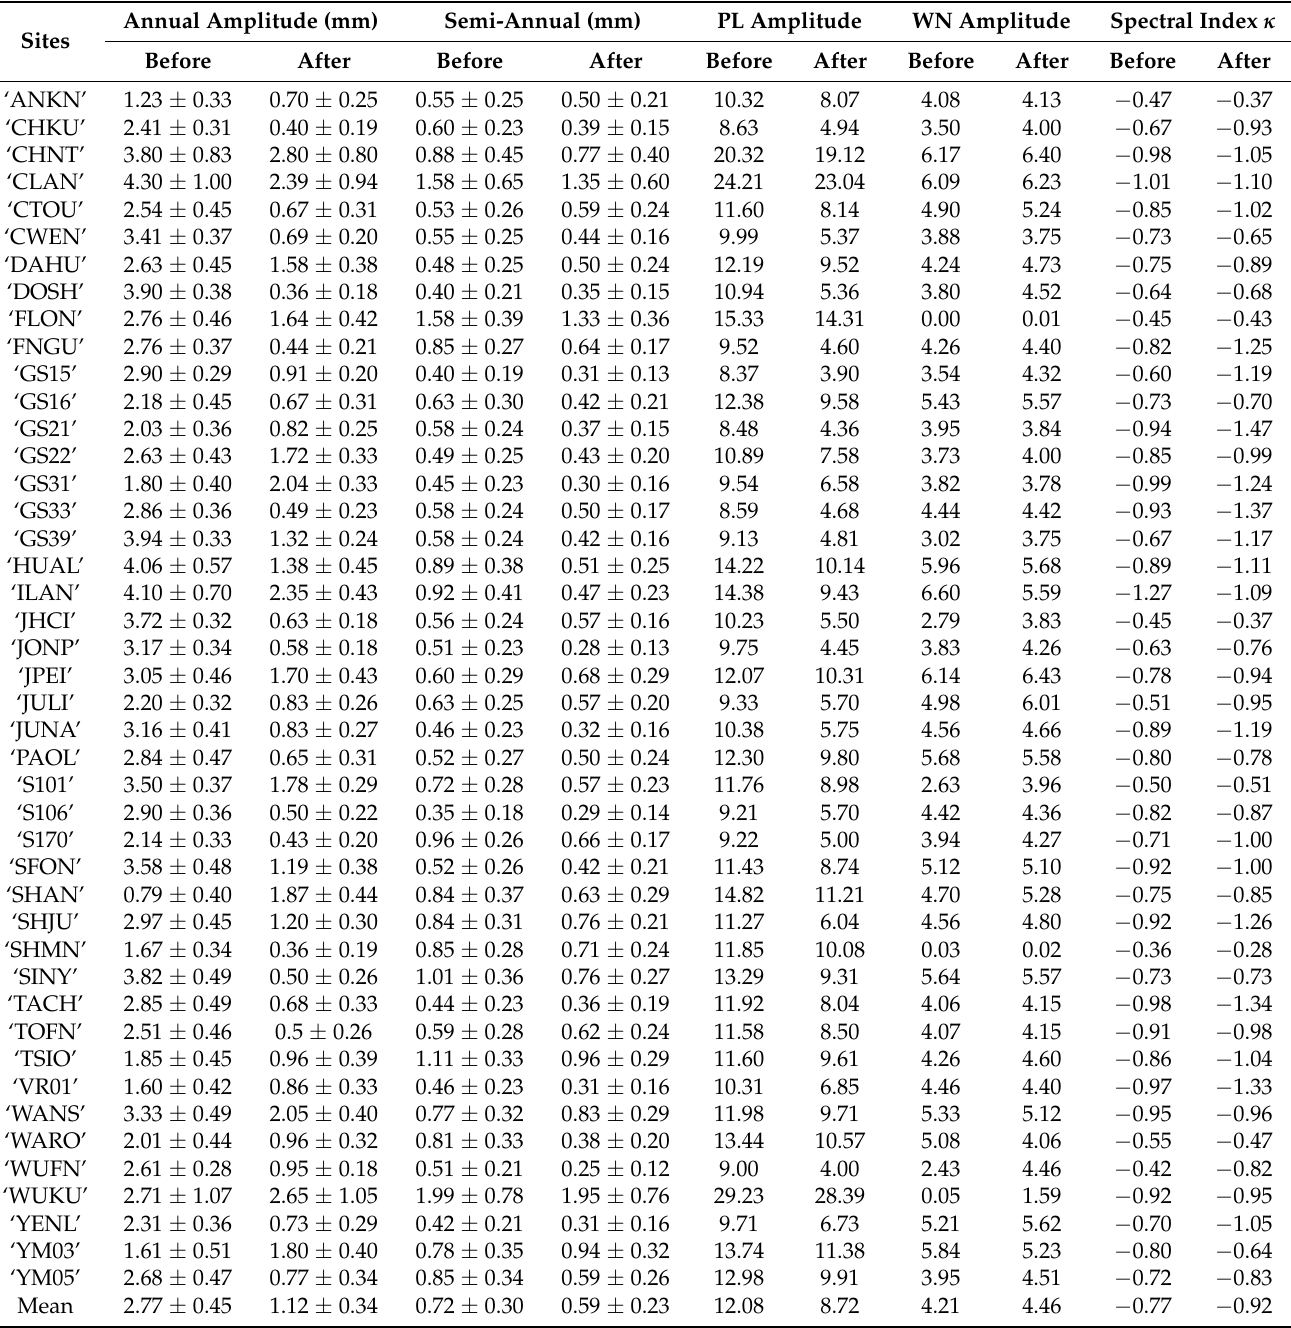
Table 3. Estimated parameters using Hector software before and after spatiotemporal filtering